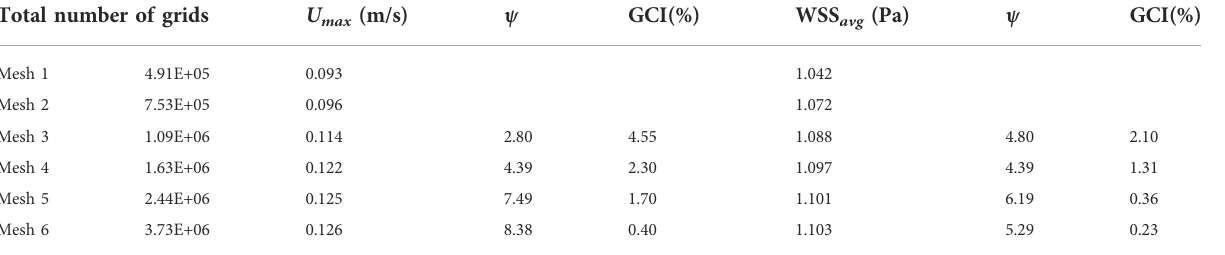
TABLE 2 Quantitative analysis of CFD grid uncertainty. Total number of